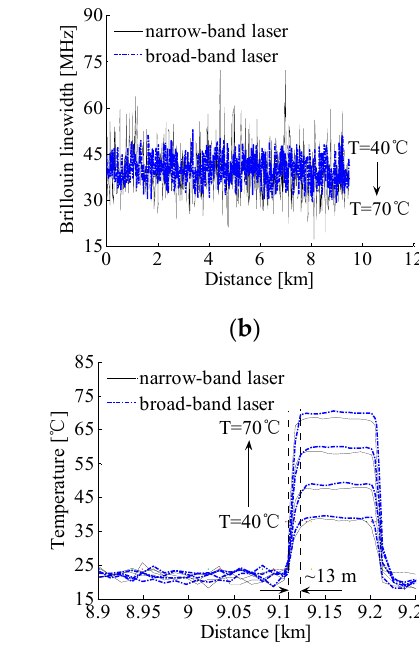
Figure 9. 3D power spectra of the self-heterodyne detection Brillouin signals with a ( a ) narrow-band laser and ( b ) broad-band laser. The temperature of the thermostatic water bath is set at 50 °C.